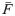
Maps of fringed myotis (Myotis thysanodes) occurrence locations in western North America and projected change in adult female fertility rates using future climate projections derived from the General Ensemble Model for year 2070 using the four representative concentration pathways (RCP2.6, RCP4.5, RCP6.0, RCP8.5).Fringed myotis locations are indicated by black stars, and our study area near Boulder, Colorado is indicated by a white star. The color ramp indicates the change (Δi) in estimated fertility rate for a given cell on the map, using the estimated mean derived from the 11 future climate models when comparing 1950–2000 climate to year 2070 projections for the ensemble model. Darkest red indicates no change between 1950–2000 climate and future climate projections, and darkest blue indicates greatest negative change. Mean projected adult fertility rates for the fringed myotis locations (F¯) and the mean change (Δ¯) from current climate conditions are also shown.